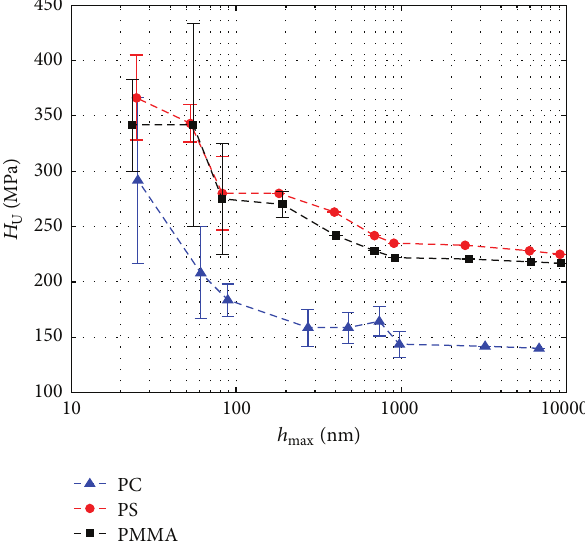
Figure 15: Universal hardness of thermoplastic polymers [15] obtained from the same experiments of Figure 14 (10s loading, holding, and unloading times together with 0.1 s −1 strain rate).